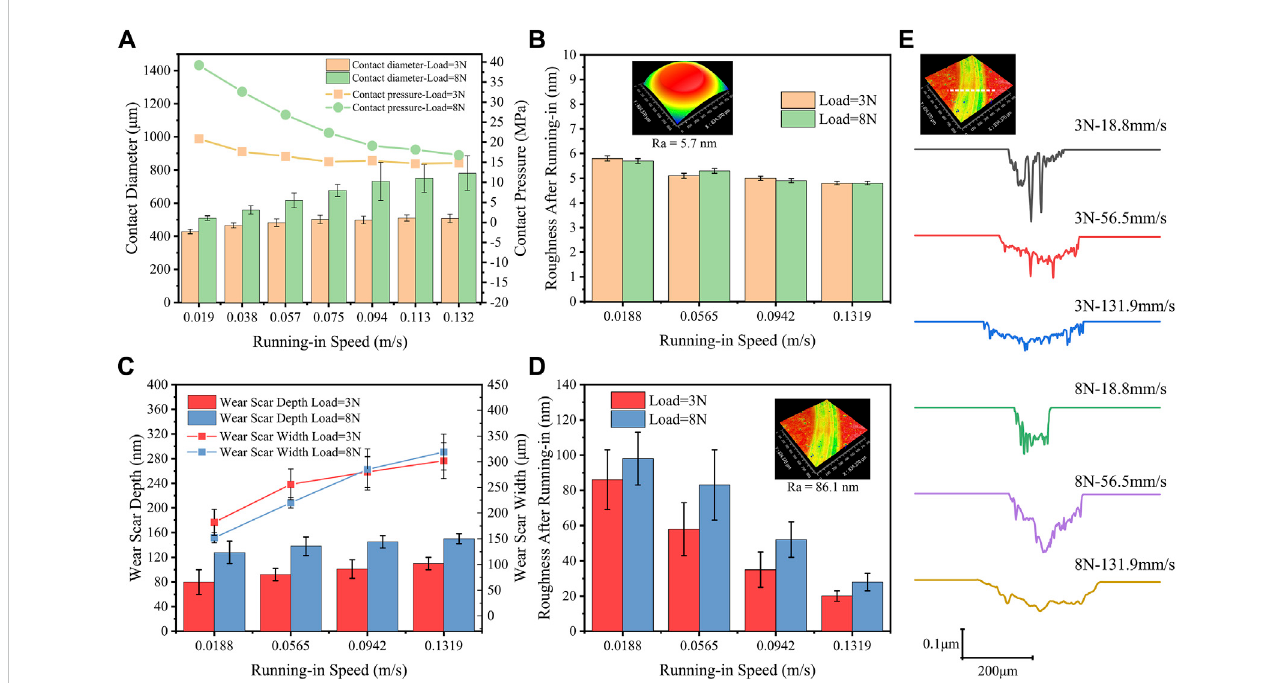
FIGURE 4 (A) Diameters of the wear scar and (B) roughness on Si 3 N 4 balls under running-in loads of 3 N and 8 N and running-in speed from 0.0188 m/s to 0.1319 m/s(thehistogram)and thecorresponding calculated contact pressure (thepoint plot).The running-in distance was16.96 m. (C) Wearscarwidth and depthand (D) roughnessofTiO 2 platesafterrunning-inatdifferentrunning-inspeedsandloads. (E) OpticalimageofthewearscaronTiO 2 wasonthelefttop, and the white line represents the cross section of the wear scar. Different cross sections under diverse running-in conditions are shown